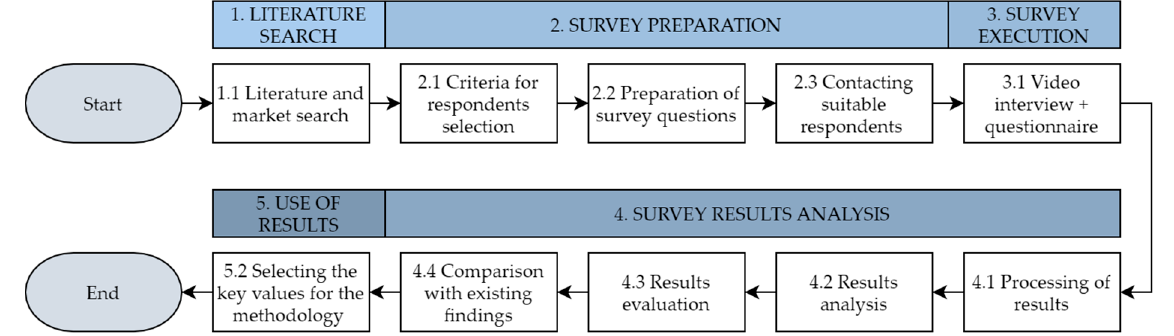
Figure 1. Process map of the research methodology.